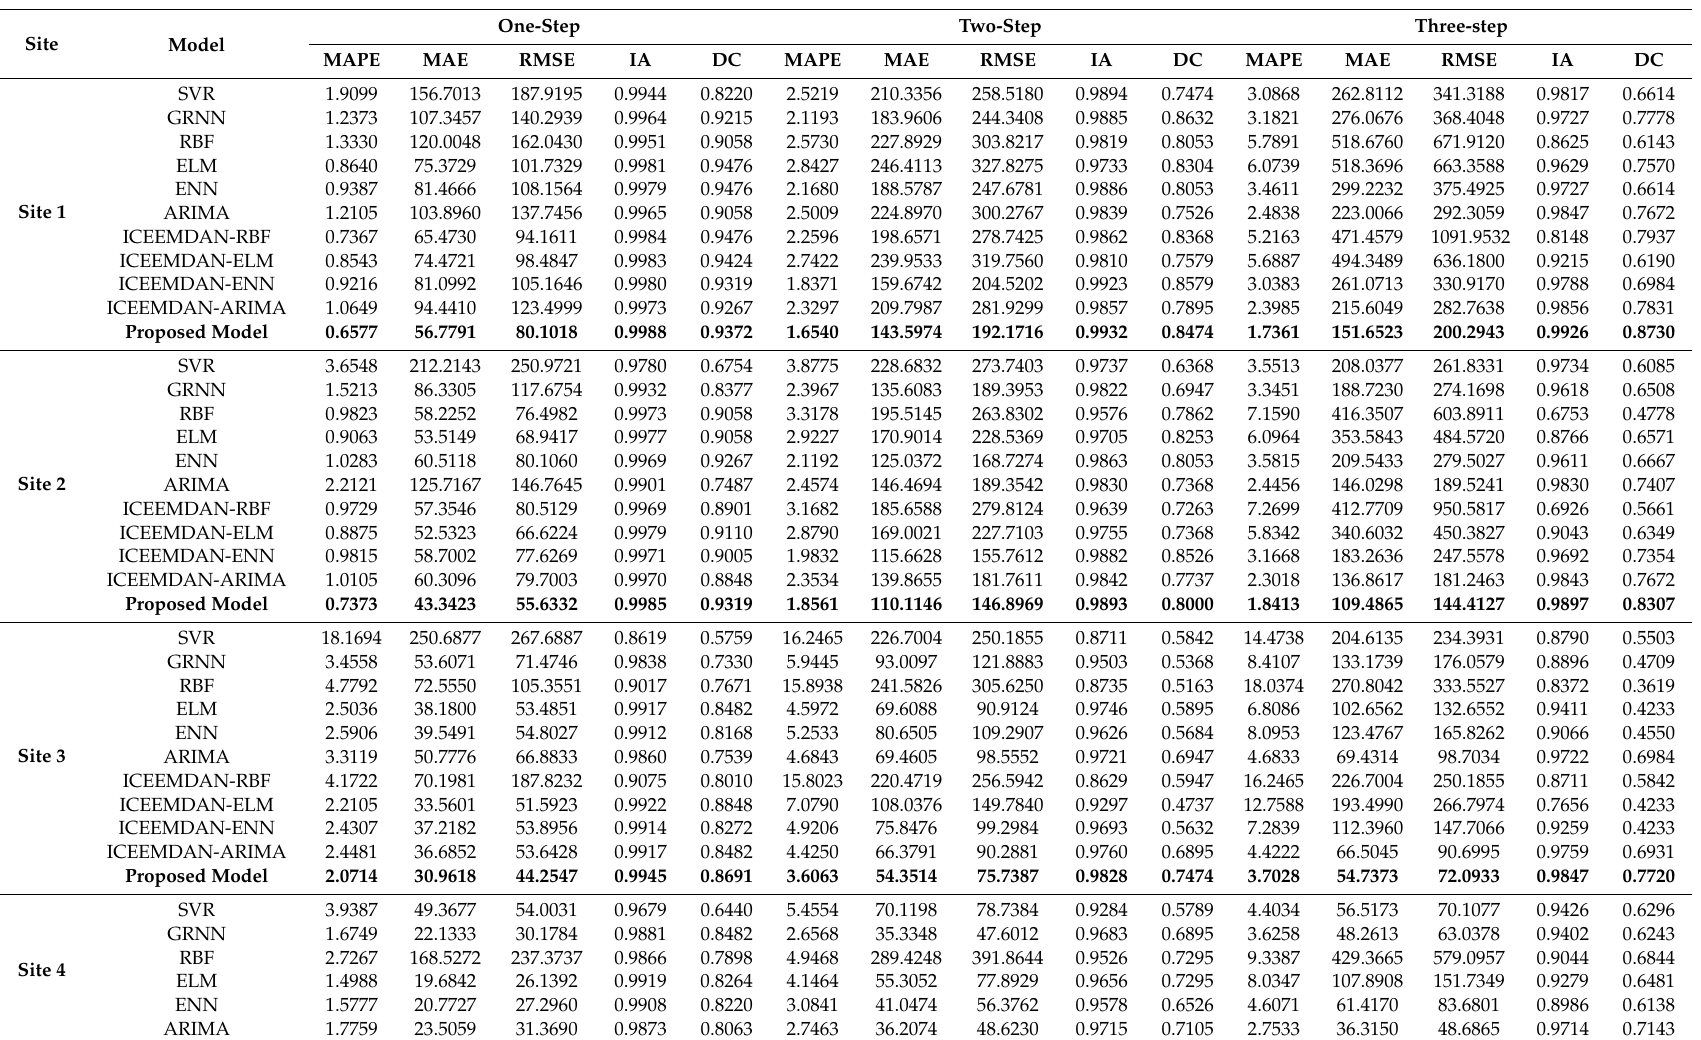
Table 5. Abilities of the established model and single